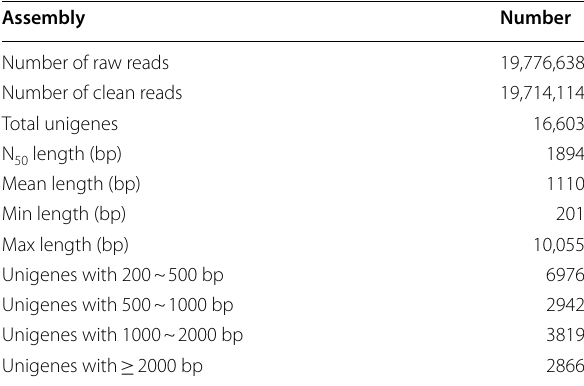
Table 1 Assembly summary of C. cladosporioides MD2